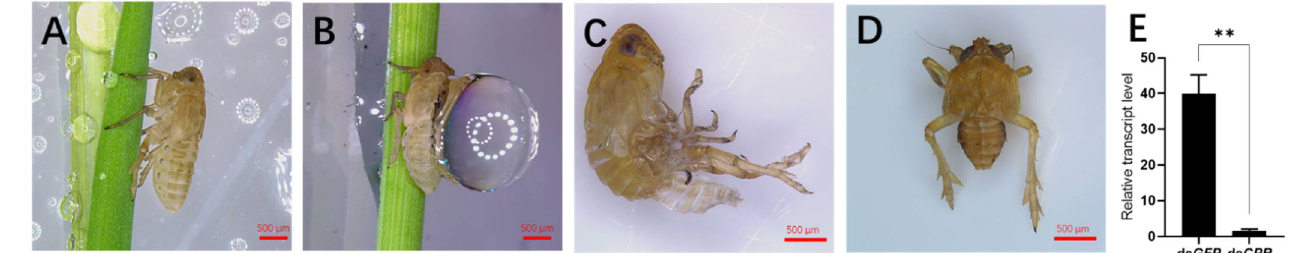
Figure 2. Phenotypes of RNAi. Each dsRNA was injected in the 4th-instar nymphs at 48 h after hatching. Phenotypes were observed in ds GFP - ( A ) and ds CPR -injected nymphs ( B – D ). ( E ) RNAi efficiency of the CPR gene, the asterisk ** indicate significant differences at p < 0.01 (Student’s t -test), difference from ds GFP . Mean ± SE were calculated from three biological